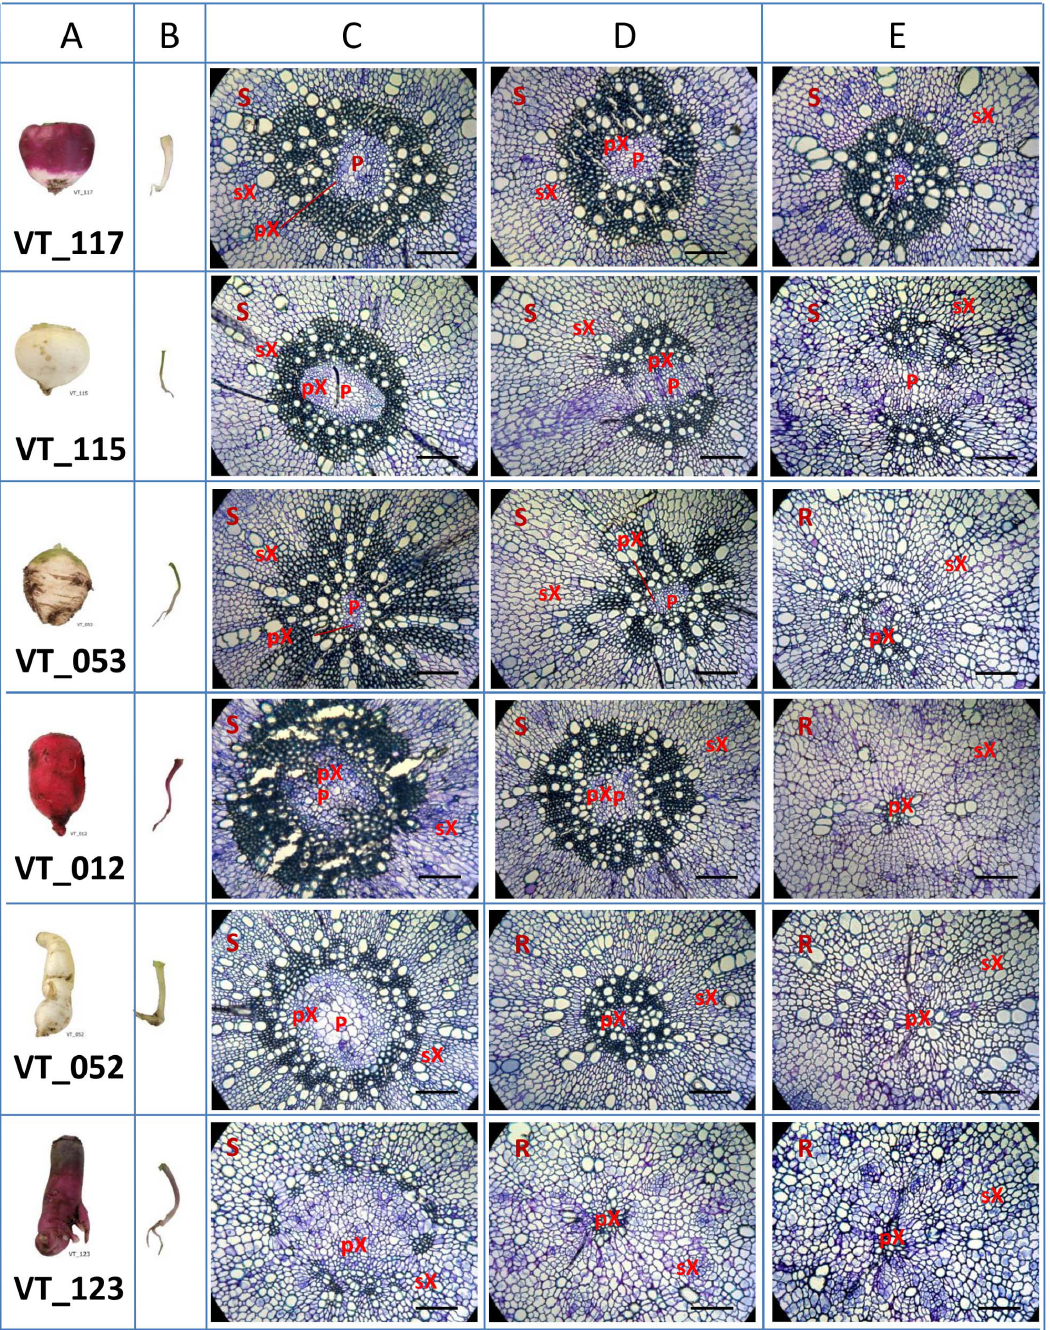
Figure 1. Mature turnips, 28 day old seedling turnips and cross sections of 28 day old turnips of six accessions. The mature turnip tuber and the 28 day old seedling are separated in column A and B of the corresponding accession; followed by sections derived from the turnip tuber of a 28 day old seedling displayed in column C, D and E. All light microscopic images are the middle field of each cross section with the scale bar standing for 100 m m. Column C shows the cross sections of the upper part of the tuber (5 mm below the cotyledons); D shows the middle part of the tuber; E shows the lower part of the tuber (5 mm above the bottom). At the left up corner of each section, S and R stands for stem and root structure respectively. P: Pith; pX: primary xylem; sX: secondary xylem. Most of the turnips show a more dense lignified zone of first formed secondary xylem around the pith (especially in VT_012, 053 and 117), and then the wood parts becomes very weakly lignified. Lignification is the strongest in the upper parts and declines towards the lower parts. Accession VT_123 does not show significant lignification in the wood cylinder.